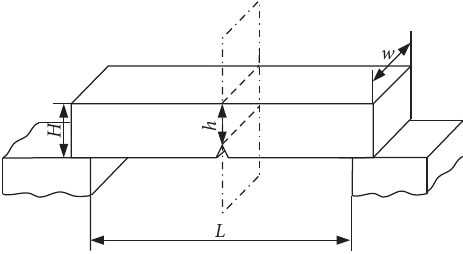
Figure 3: Dimensions of impact specimen. Table 1: Basic mechanic properties of tested